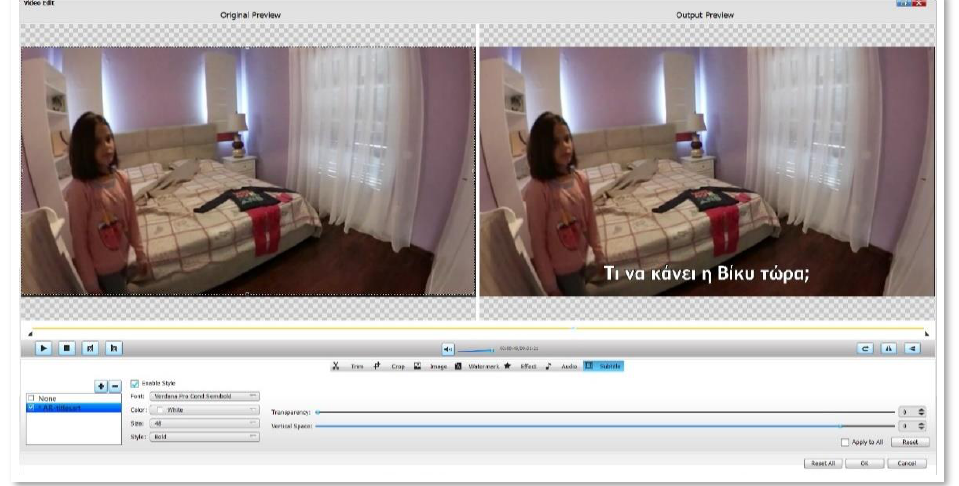
Figure 19. Post-production phase: subtitle editing. Subtitling while the pedagogical agent speaks